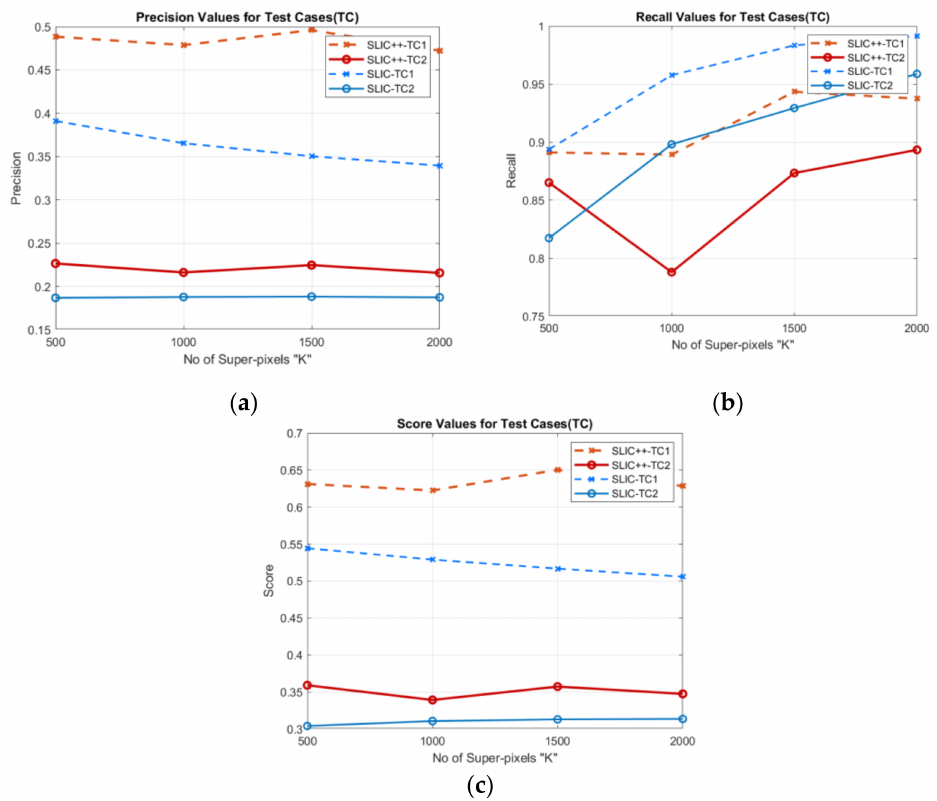
Figure 3. SLIC v/s SLIC++ performance over different number of pixels: ( a ) precision values; ( b ) recall value; ( c ) score values.